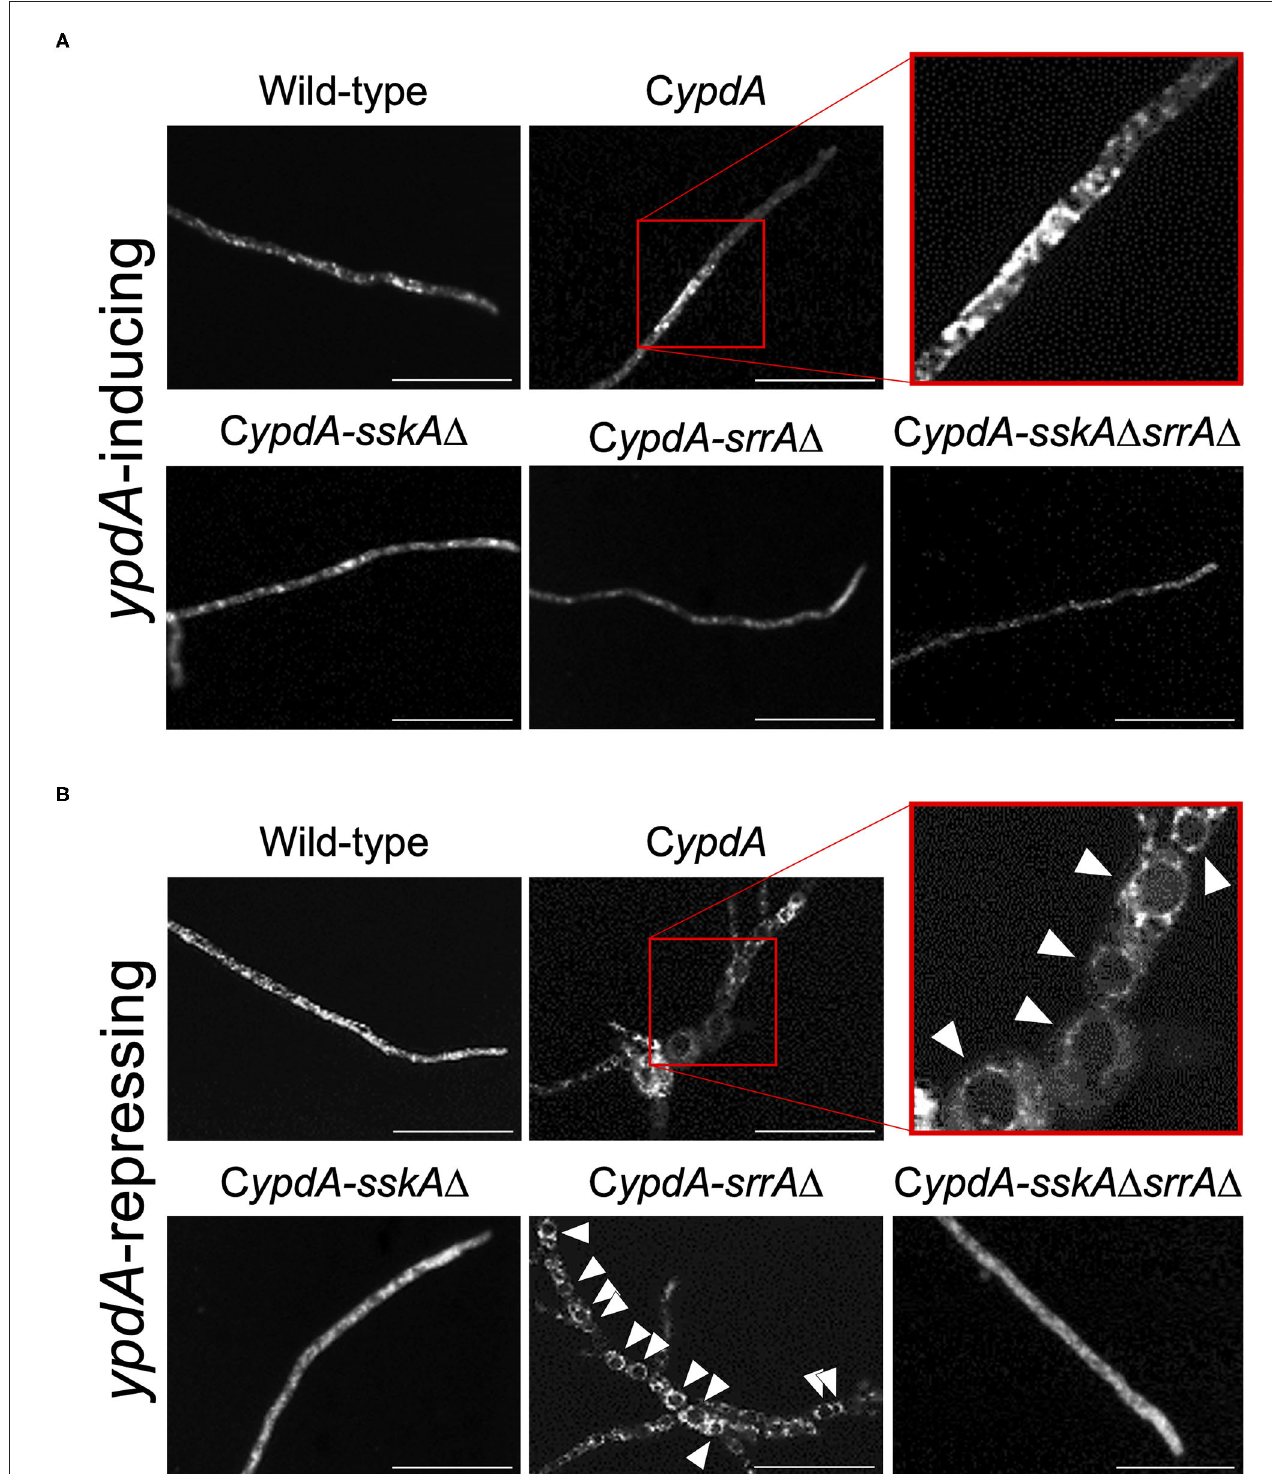
FIGURE 10 | Vacuole morphology of the wild-type and C ypdA strains under ypdA -inducing and -repressing conditions. Conidia of each strain were cultured in CDTFY ( ypdA -inducing) medium for 8h at 37 ◦ C, then transferred to CDTFY ( A , ypdA -inducing) or CDY ( B , ypdA -repressing) conditions and incubated for 4h at 37 ◦ C. After incubation, mycelia were stained with FM4-64 and vacuoles were observed by fluorescence microscopy. Arrowheads indicate vacuoles. Bars, 35 µ m.